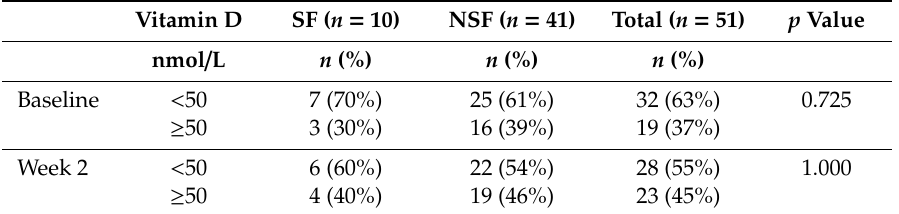
Table 3. Plasma vitamin D status of stone formers and non-stone formers at baseline and after ADEK supplementation.